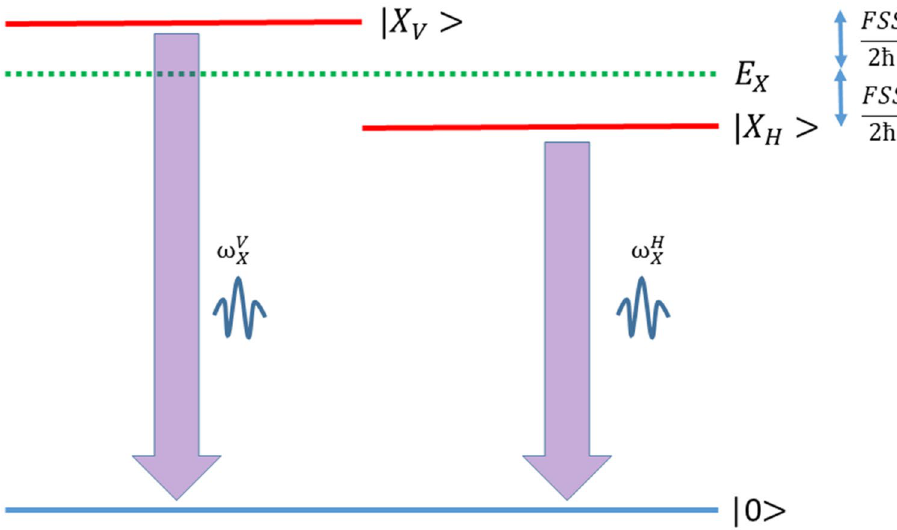
Figure 2. Graphical representation of the excitonic levels and fine-structure splitting. The zero in the energy scale is assumed to be the ground